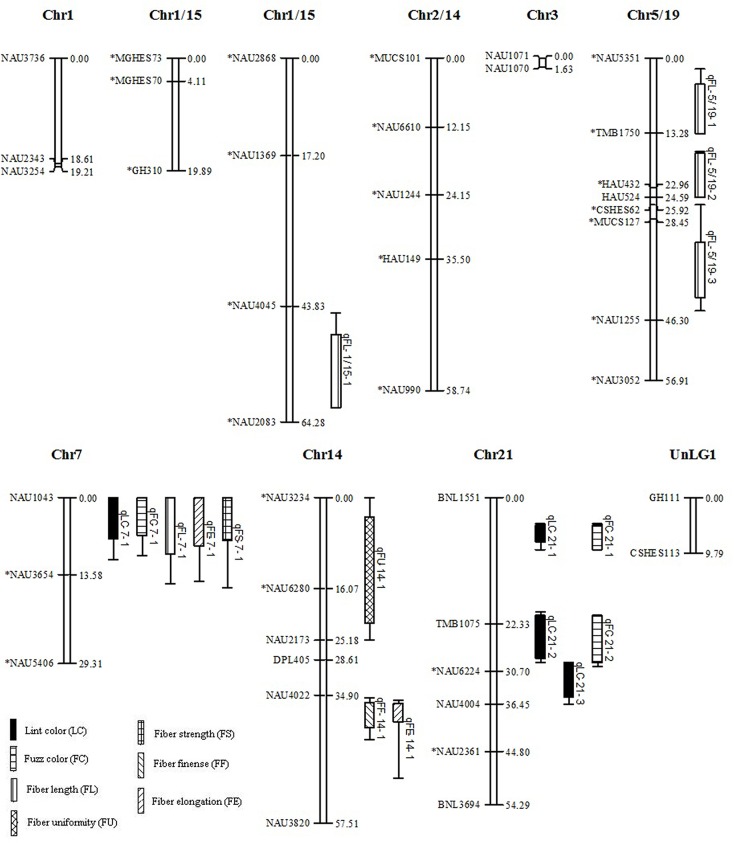
Linkage map from F2 population of Zong128 × KuchuT94-4.Linkage groups that could not be assigned to a chromosome were given the preliminary names UnLG1 UnLG2 and UnLG3. Bars and lines on the right-hand side of the linkage groups show the QTL likelihood intervals. Map distances in centimorgans (cM) are indicated on the left-hand side of the linkage groups. LC, lint color; FC, fuzz color; FL, fiber length; FU, fiber uniformity; FF, micronaire; FE, fiber elongation; FS, fiber strength; *Indicates distorted markers.